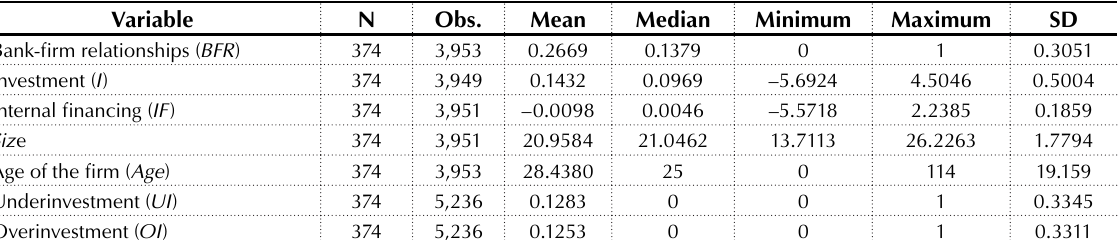
Table 1. Statistic description